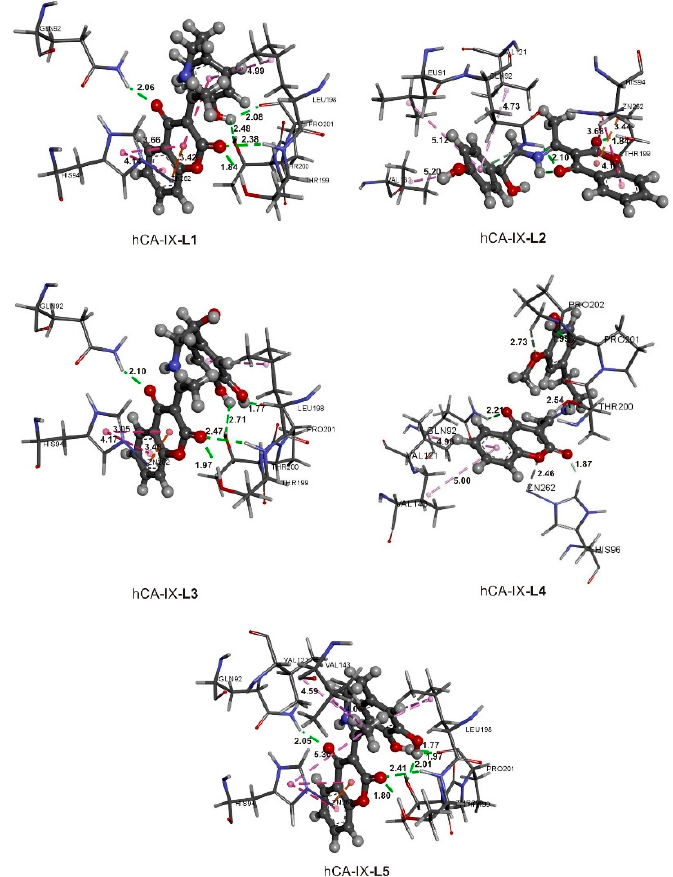
Figure 4. Predicted binding interactions between the investigated molecules and the hCA-IX re-